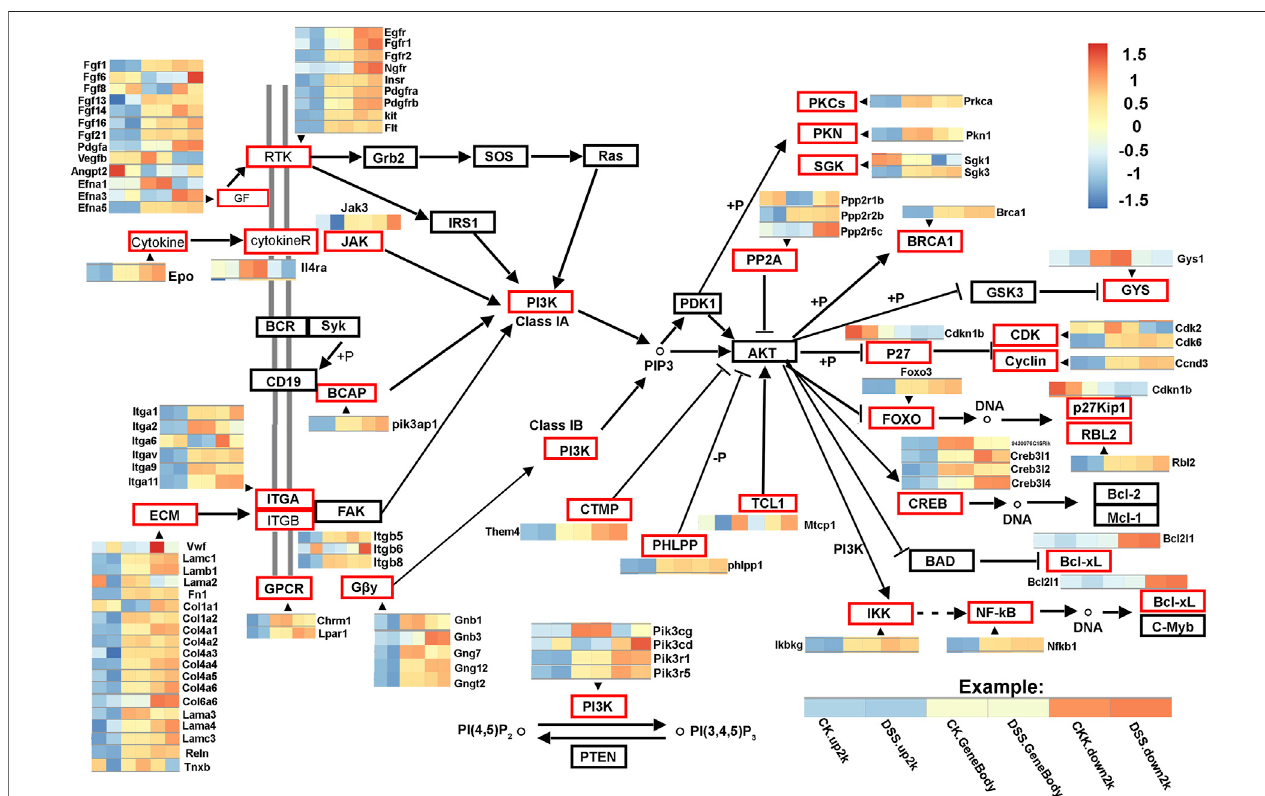
FIGURE 7 | DNA methylation in different genes of PI3K/AKT signaling pathways. The network shows differentially DNA methylated genes of PI3K/AKT signaling pathways. The gene regions (CK.gene body and DSS. gene body), 2 kb upstream of the gene regions (CK.up2k and DSS. up2k), and downstream of the gene regions (CK.down2k and DSS. down2k) in control and dextran sulfate sodium (DSS)-treated mice are analyzed. The differentially DNA methylated genes are marked in red